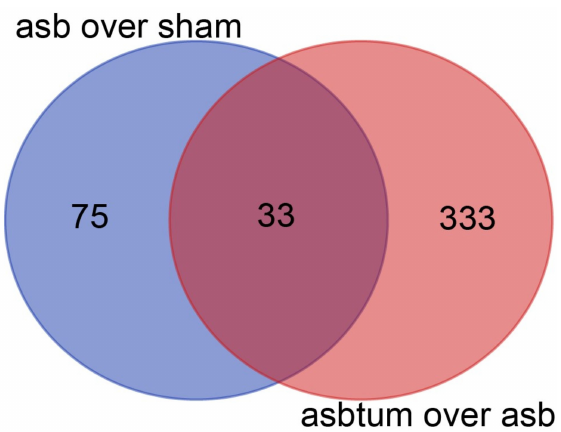
Figure 1. Overlap of the differentially expressed non-coding genes (more than 2-fold change, p < 0.01) in crocidolite-exposed vs. sham (asb over sham) and crocidolite-exposed with tumors vs. crocidolite-exposed (asbtum over asb) comparisons visualized as a Venn